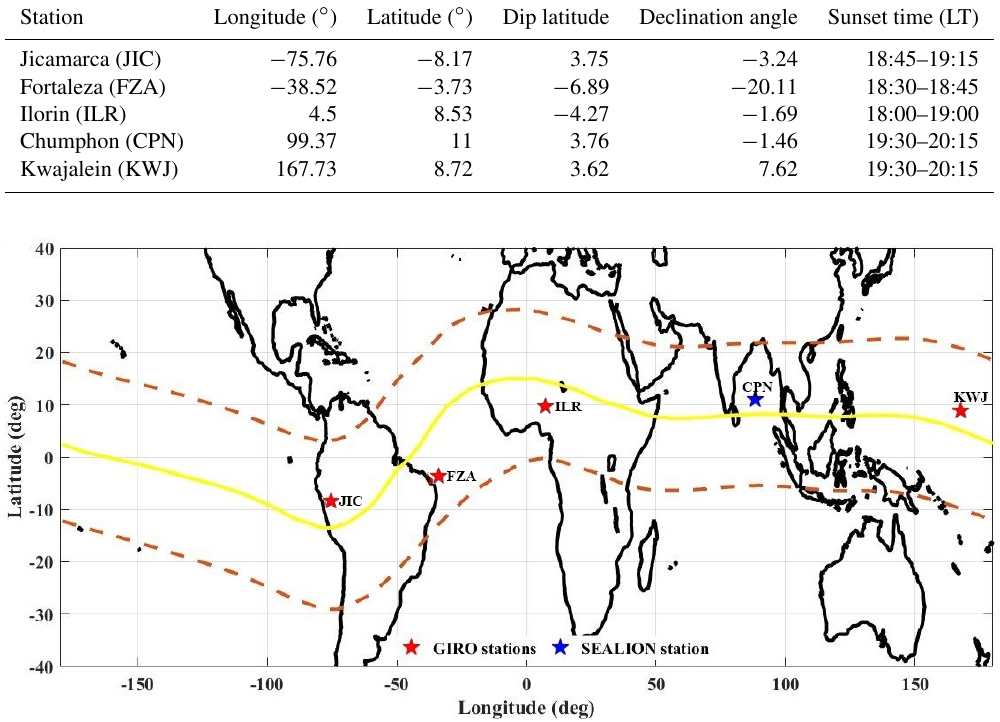
Figure 1. The geographic location of the ionosonde stations and their corresponding observatory network shown using the red (GIRO) and blue (SEALION) markers (yellow line and dashed brown line represent the Equator and ± 15 ◦ latitudes, respectively) and